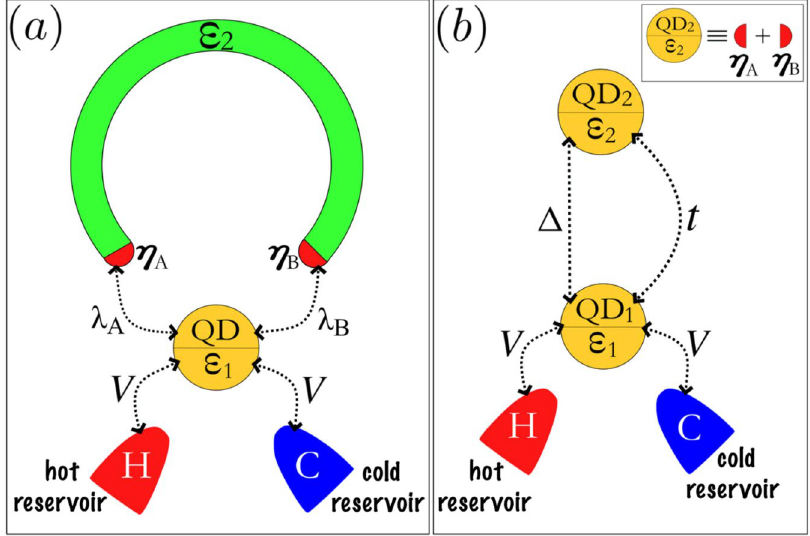
Figure 1. ( a ) The sketch of the geometry we consider. Topological U-shaped Kitaev wire with a pair of MFs η A and η B is placed in contact with a QD, which is connected as well to two metallic reservoirs. The coupling of the QD to the MFs is asymmetric and is characterized by tunneling matrix elements λ A and λ B , while coupling to the metallic leads is symmetric and is characterized by the tunneling matrix element V . ε 2 denotes the coupling between two MF states. ( b ) Equivalent auxiliary setup (Kitaev dimer) resulting from the mapping of the original system onto the system with nonlocal fermion residing in QD 2 . t is tunneling matrix element between the QDs 1 and 2, Δ is the binding energy of the Cooper pair delocalized between